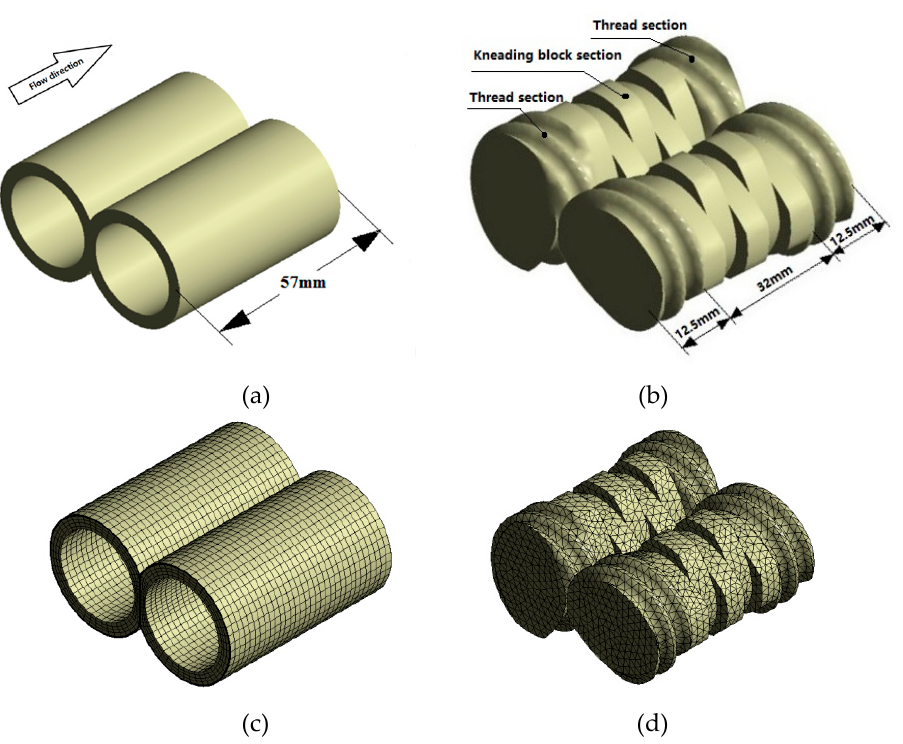
Figure 1. Geometrical and FE models: ( a ) Geometry of flow channel; ( b ) geometry of combined screws; ( c ) FE model of flow channel; ( d ) FE model of two screws.